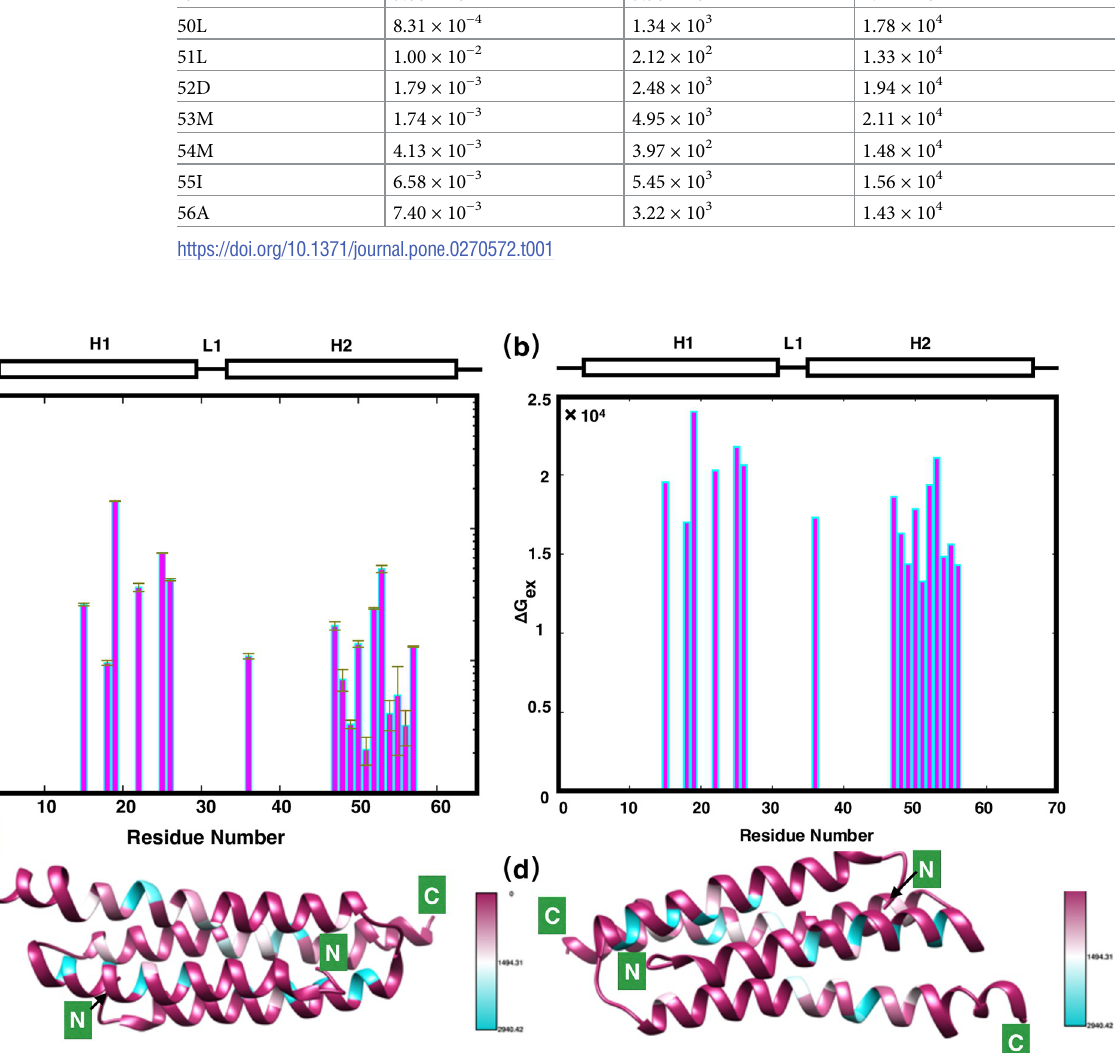
ranges are: fast exchangers (purple) Δ Gex � 30000; ex